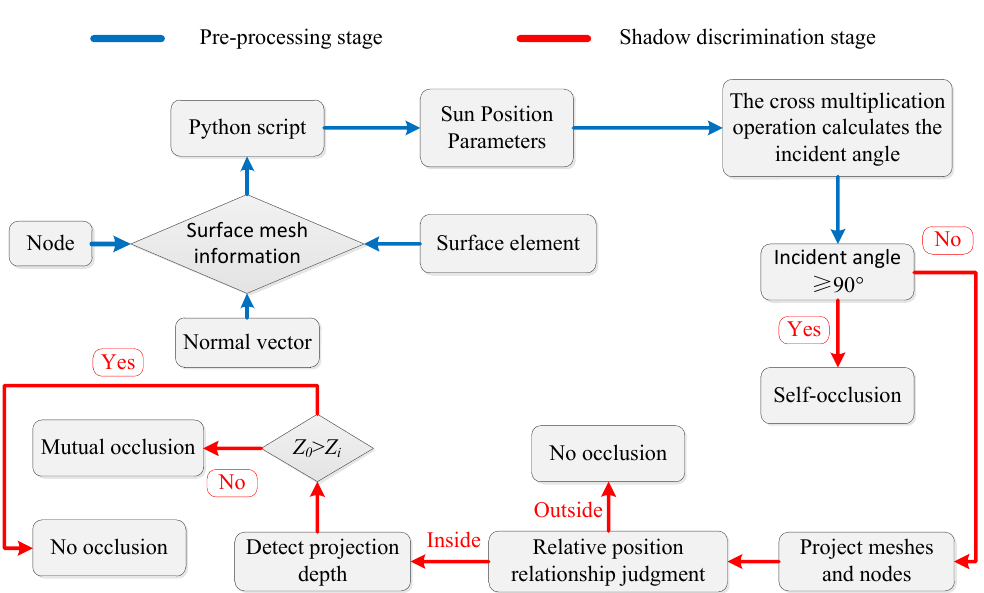
Figure 6. Sunshine shadow recognition technology implementation process.